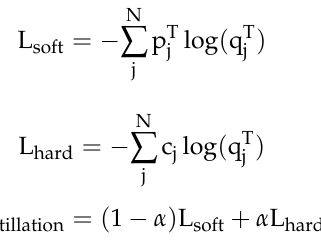
Figure 7. Distillation process.